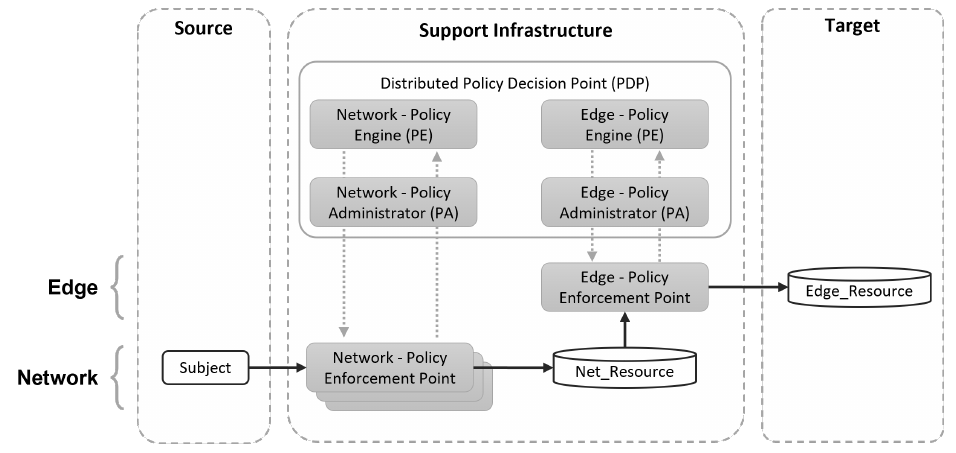
Figure 5. Two-layered Zero-Trust Solution